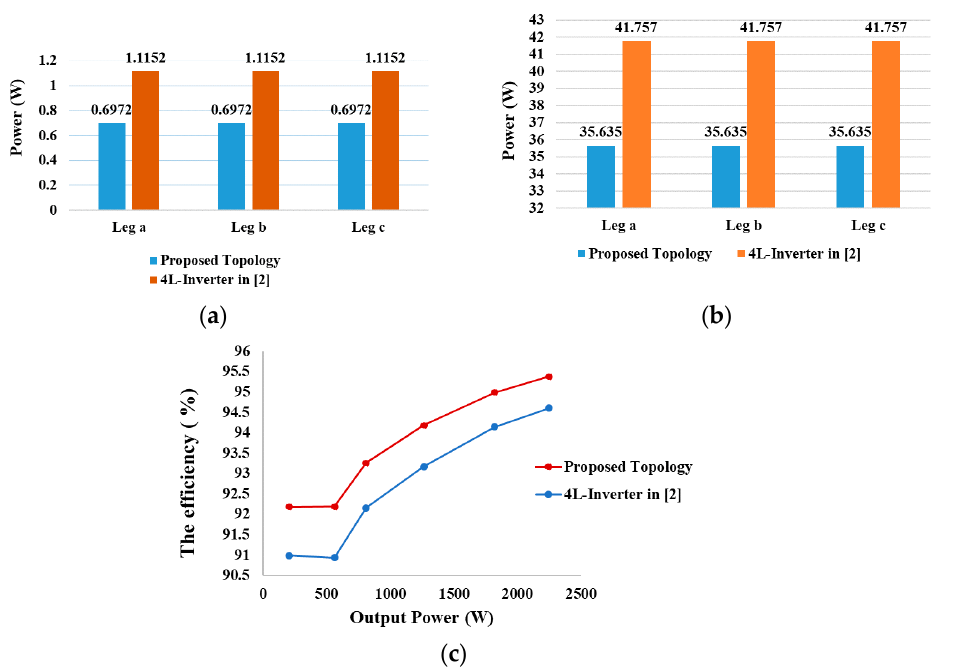
Figure 9. Comparison of calculated losses and efficiency between 4LT 2 C and the four-level inverter in [2]: for M a = 1 and P out = 2.250 kW. ( a ) Switching losses in each leg. ( b ) Conduction losses in each leg. ( c ) Efficiency as the output power increases to 2.25 kW.